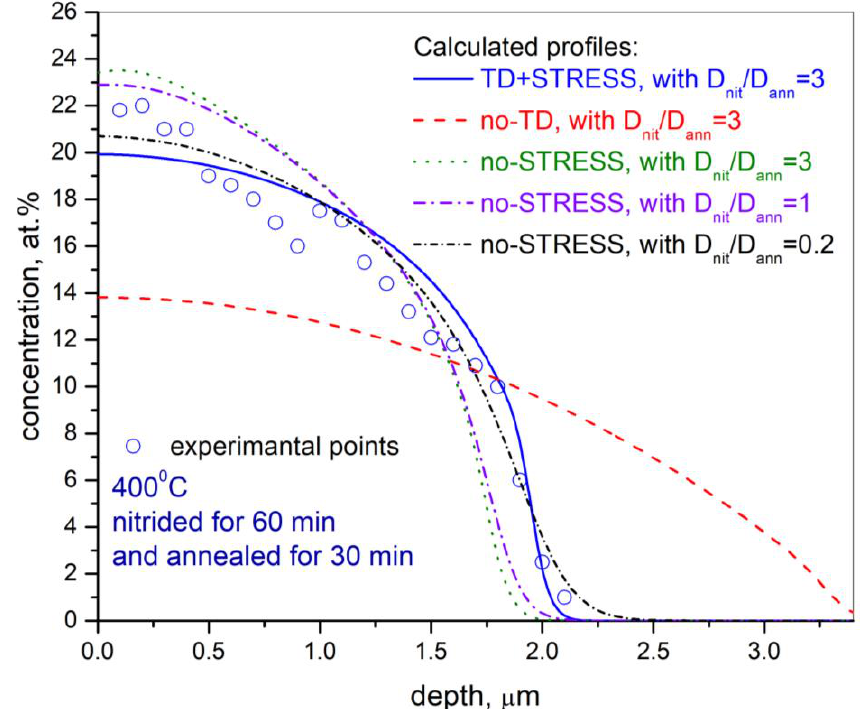
Figure 6. Calculated depth profiles of total nitrogen in the (100)-oriented single crystal of ASS for three cases, including: (1) both processes (trapping/detrapping (TD) and stress-induced diffusion (STRESS)) (curve for TD + STRESS), (2) only the process of STRESS (curve for no-TD), and (3) only the TD model (curves for no-STRESS with different D nit /D ann ratios). Experimental results (points) are taken from Ref. [53].